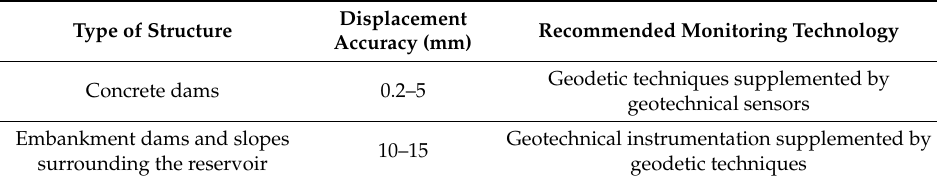
Table 1. Accuracy requirements of monitoring schemes.